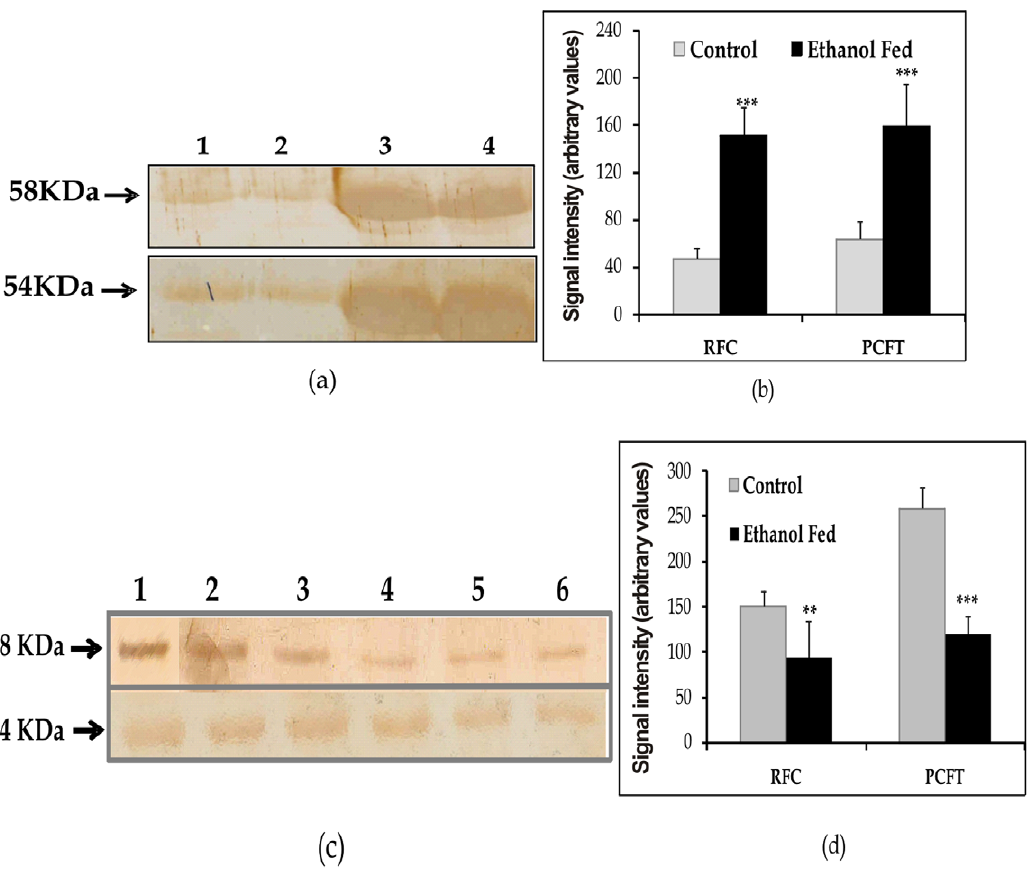
Figure 5. Western blots analysis of pancreatic tissue lysate (a) using anti RFC (58 kDa), anti PCFT (54 kDa) antibodies (b) Graph represents summary data of densitometric analysis, lane 1,2: Control; 3,4: ethanol fed. Western blot analysis of the PPMV (c) using anti RFC (58 kDa), anti PCFT (54 kDa) antibodies (d) Graph represents summary data of densitometric analysis. Data are expressed are means 6 SD of 4 separate experiments. Lane 1–3: Control; 4–6: ethanol fed. ** p , 0.01, *** p , 0.001 vs.